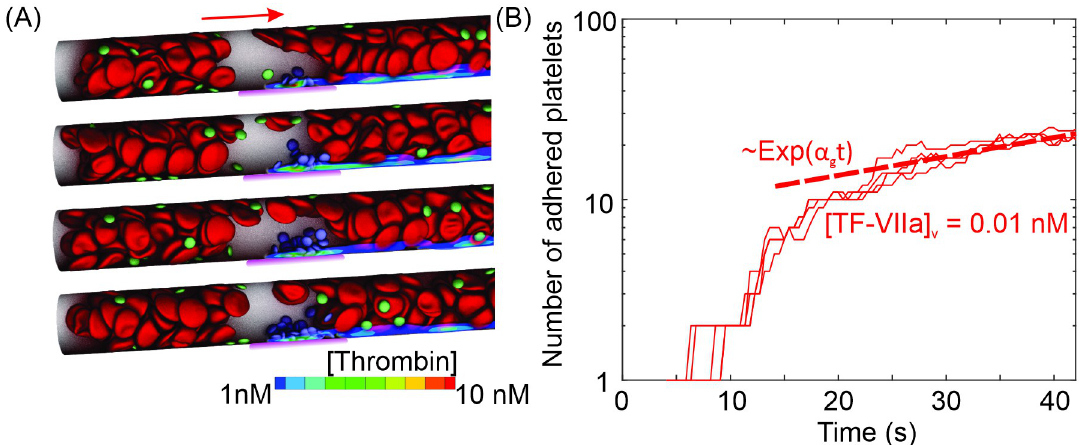
Fig 3. Platelet activation and adhesion driven by the coagulation cascade at the thrombogenic site. (A) Four sequential snapshots of platelets activation and adhesion at the thrombogenic site (highlighted by magenta). Passive platelets (green) become activated and adhesive after exposing to [FIIa] � 1 nM, which is described by the concentration field in the figure. RBCs close to the thrombogenic site are not plotted for virtualization of the platelet aggregate. Blood flows from left to right. See S1 Movie. (B) Typical examples of the number of adhered platelets at the thrombogenic site vs. time (t), plotted in semi-log axes. The exponential growth rate is computed by fitting the data using dotted lines. Each of the growth rate measurement consists of four stochastic realizations to compute the mean and standard